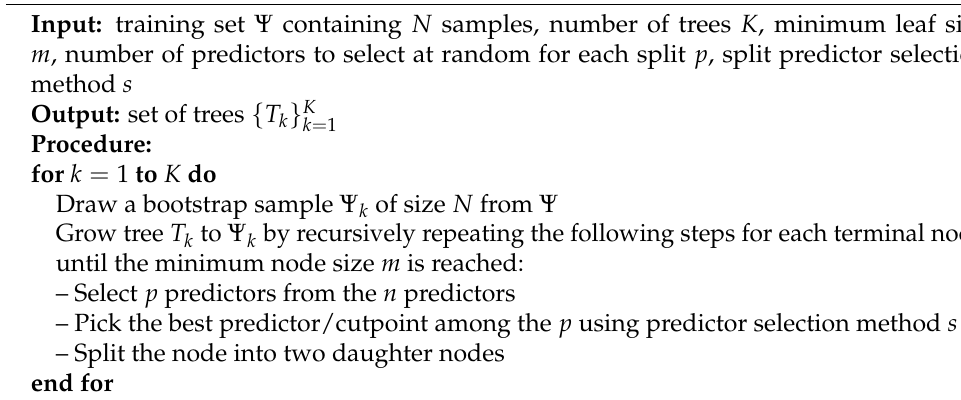
Algorithm 1 Random forest construction for